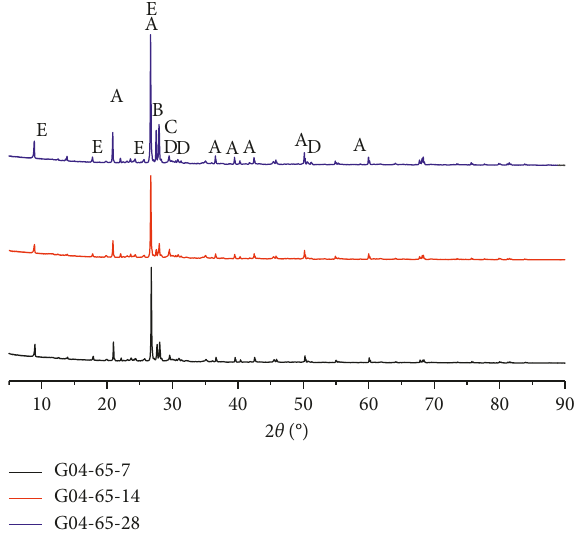
Figure 6: X-ray diffraction pattern of GP-CTB samples. (A) Quartz; (B) feldspar; (C) calcite; (D) C-S-H gel; (E) muscovite.